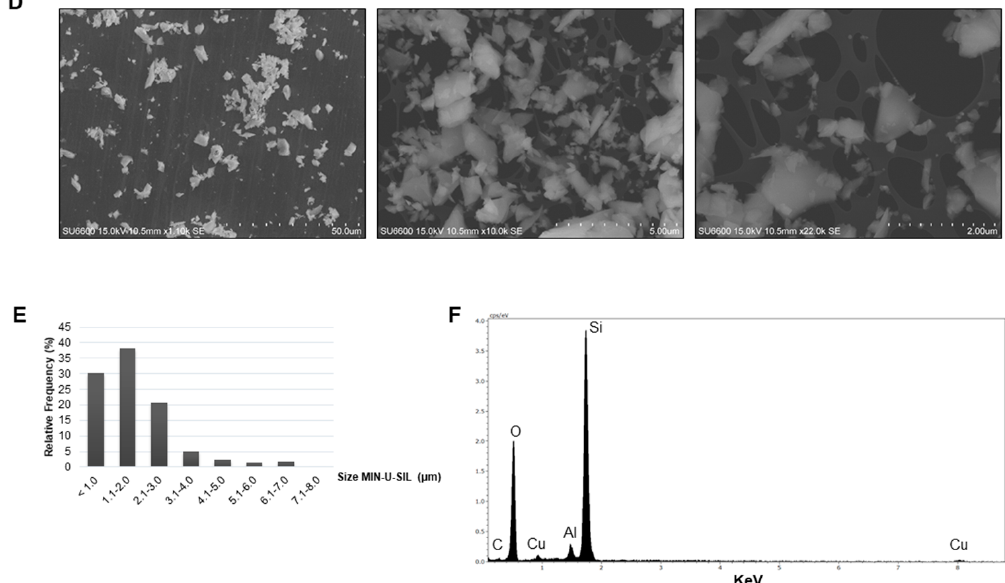
Figure 1. Characterization of the dry dust by scanning electron microscope (SEM). ( A ) Representative SEM images of the amorphous SiO 2 .; ( B ) The diameter (nm) of the dust particles was measured and the relative frequency in percentage is shown for the different size groups ( n = 300); ( C ) Energy-dispersive X-ray spectrum showing the elemental content of the amorphous SiO 2 dust; ( D ) Representative SEM images of the crystalline SiO 2 MIN-U-SIL; ( E ) The diameter (µm) of the MIN-U-SIL dust particles was measured and the relative frequency in percentage is shown for the different size groups ( n = 300); ( F ) Energy-dispersive X-ray spectrum showing the elemental content of the crystalline SiO 2 dust.